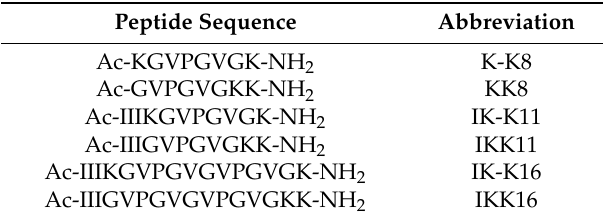
Table 1. Sequences of the designed short elastin-based